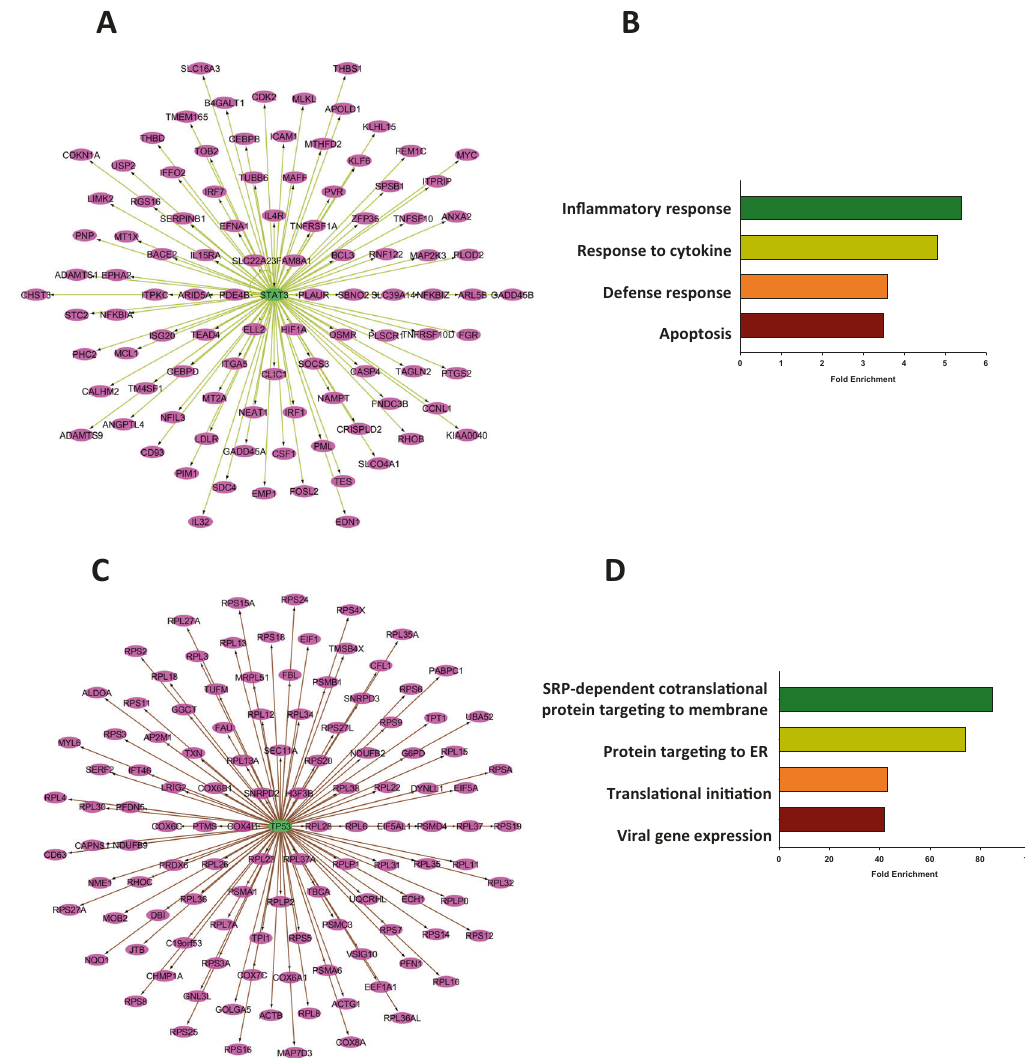
Fig. 2 Transcription factors and their target genes in the PFC_M4 and the PFC_M5 module. Visualization of STAT3-target gene network in the PFC_M4 module ( A ), Biological processes signi fi cantly enriched in the network ( B ). Visualization of p53 -target gene network in the PFC_M5 module ( C ) and biological processes signi fi cantly enriched in the network ( D